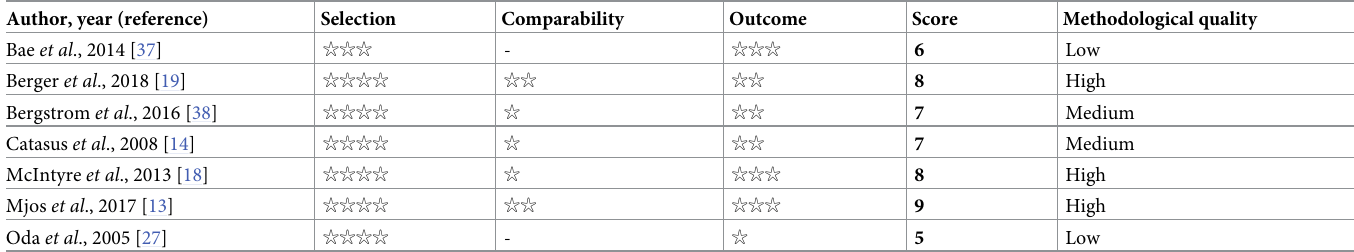
Table 3. Quality assessment of the included studies according to the Newcastle-Ottawa Scale.